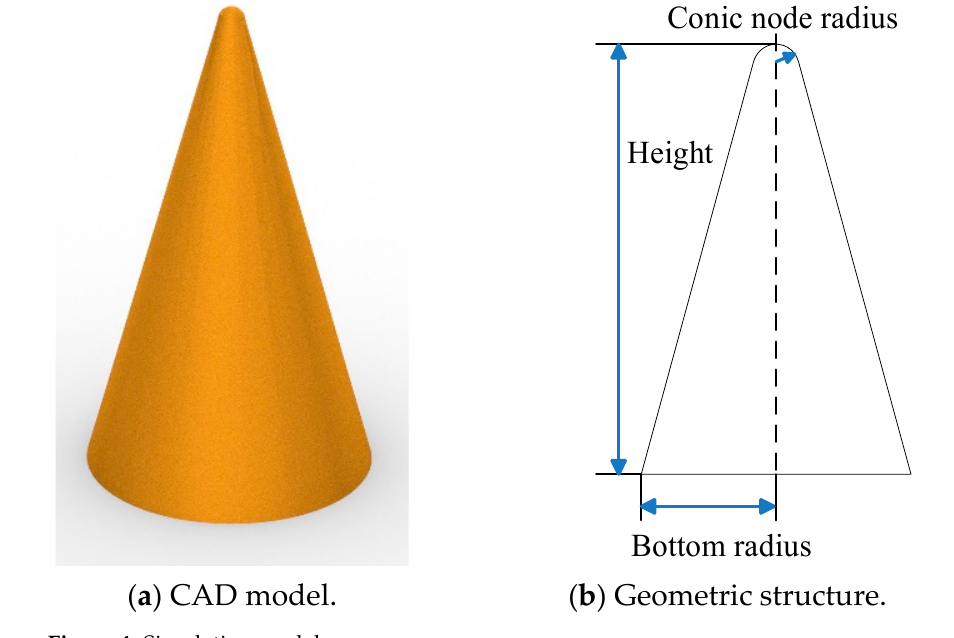
Figure 4. Simulation model. Table 2. Parameters of EM model.